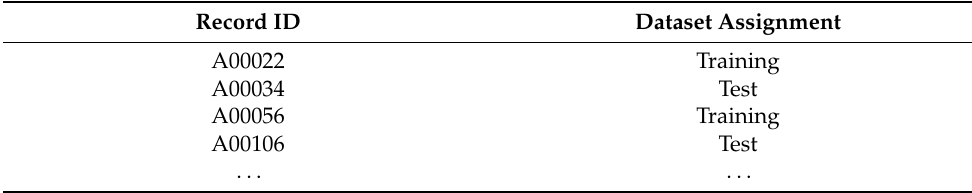
Table 3. Division of PhysioNet ECG records between the training and test